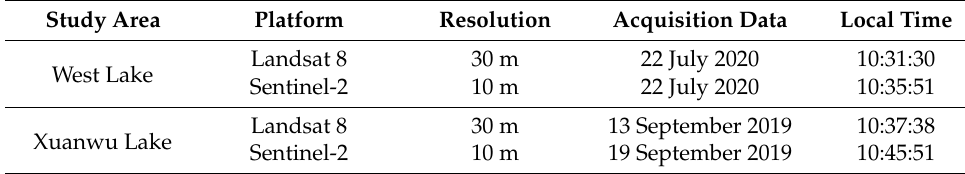
Table 1. Information of the remote sensing data used in this study. Study